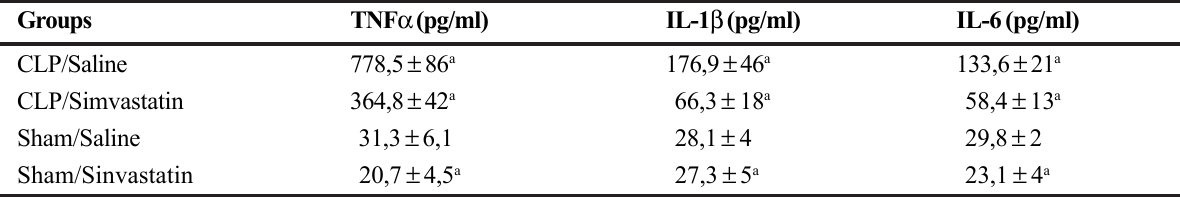
TABLE 2 - Values of TNF α , IL-1 β e IL-6 from the studied rats